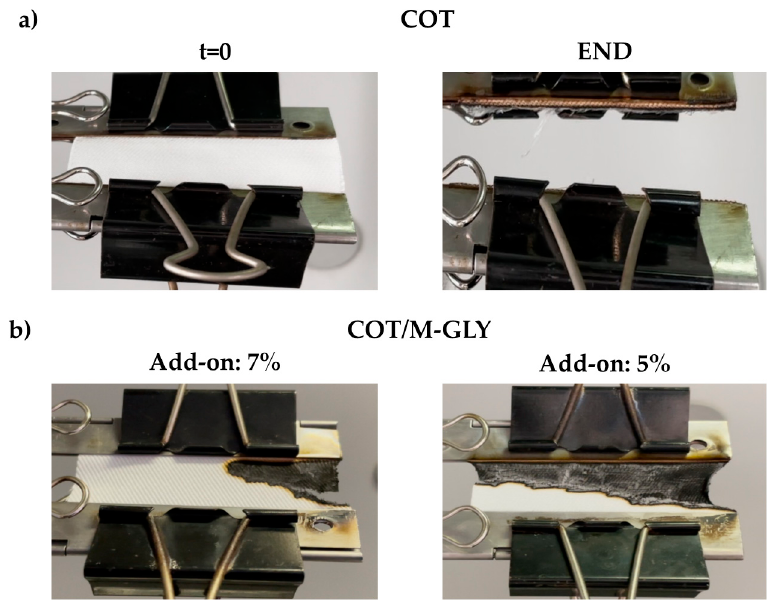
Figure 6. Snapshots of untreated cotton at the beginning and at the end of an HFST ( a ) and of M-GLY-treated cotton with add-ons, 7% and 5%, at the end of an HFST ( b ). COT/M-ALA